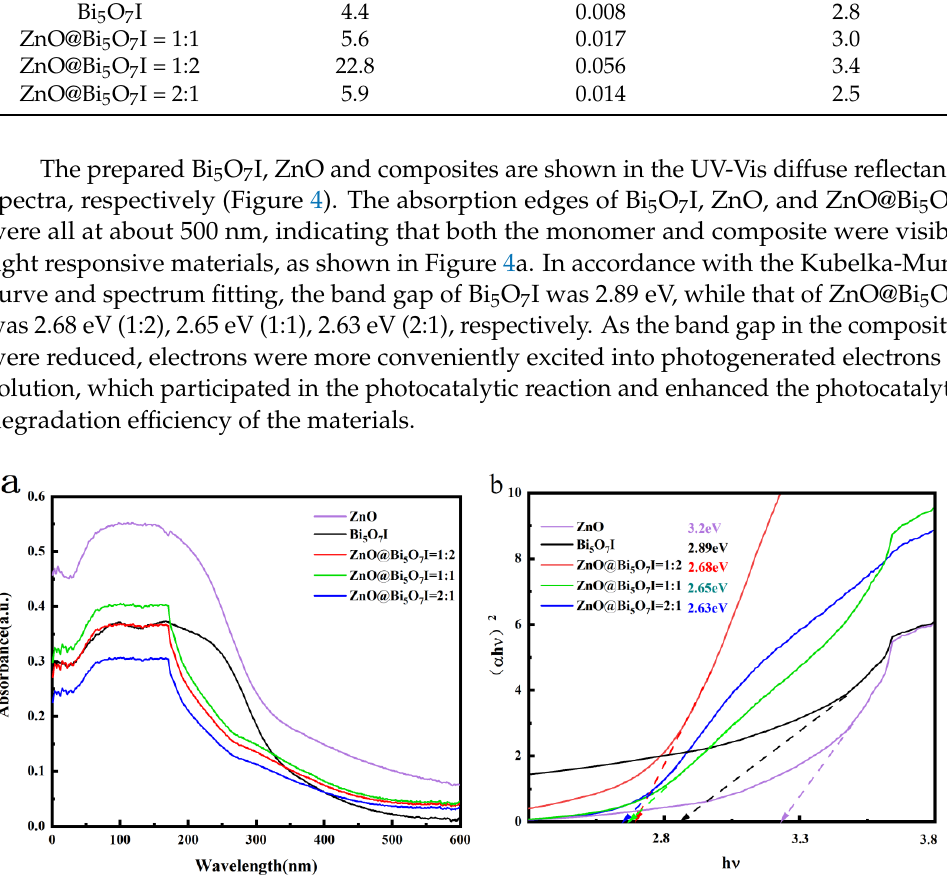
Figure 3. N 2 adsorption and desorption isotherms. Table 1. Specific surface, pore characteristics, and crystallite sizes of the samples.